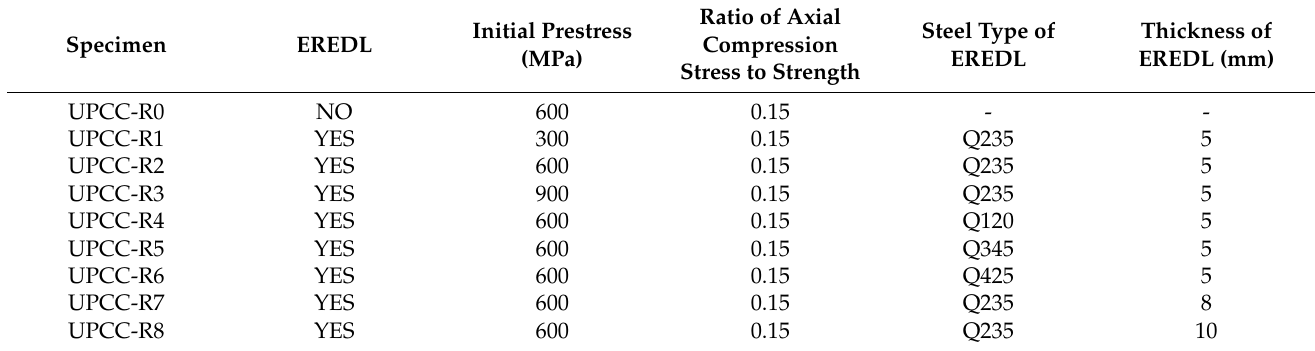
Table 1. The specific working condition of each bridge pier finite element